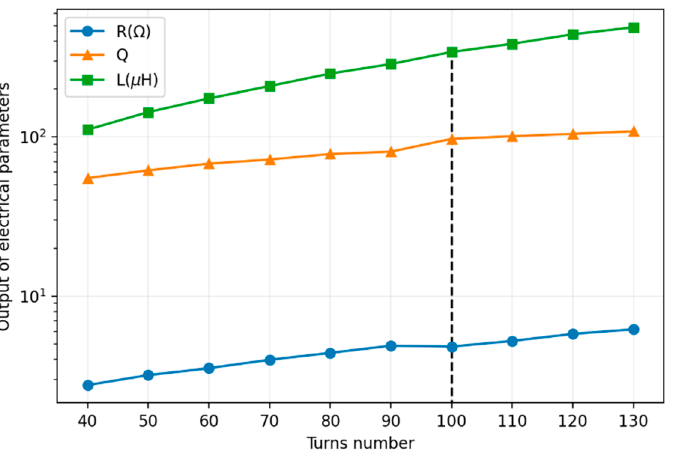
Figure 8. The relationship between the electrical parameters of the receiving coil and the number of turns.